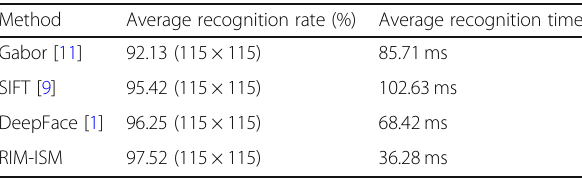
Table 1 10-fold cross-validation comparison of MIT-CBCL database